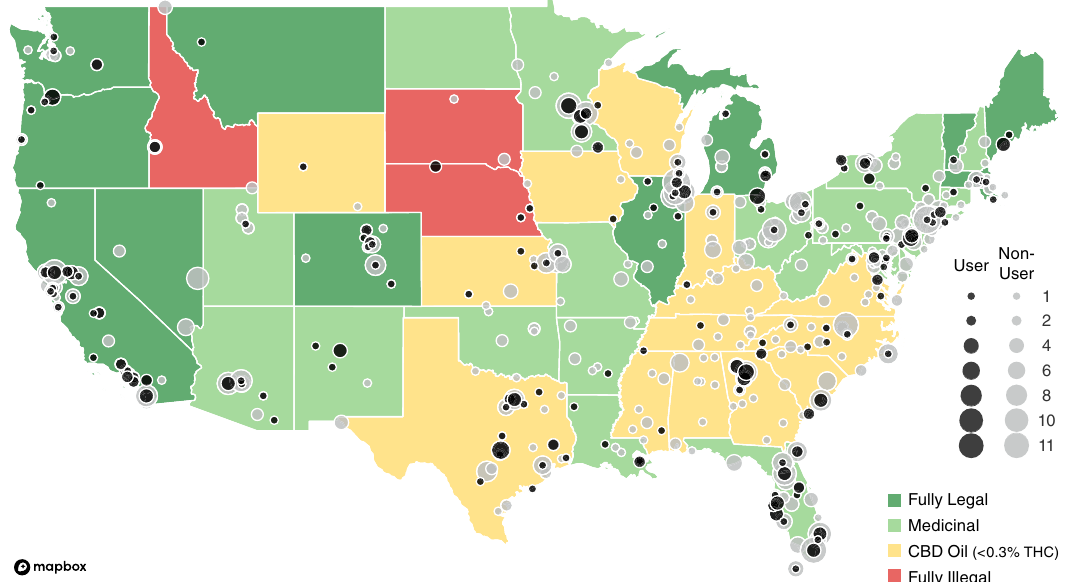
Fig. 1 A Geographic representation of survey participants. Color of state depicts the legality of cannabis as of October 2020. Black dots represent respondents who identi fi ed as cannabis users and gray dots represent respondents who identi fi ed as non-users. Dot size corresponds to number of respondents by zip code. Rhode Island was the only state without survey respondents. Not shown are Alaska and Hawaii with 2 and 1 non-user, respectively. Outline of US from